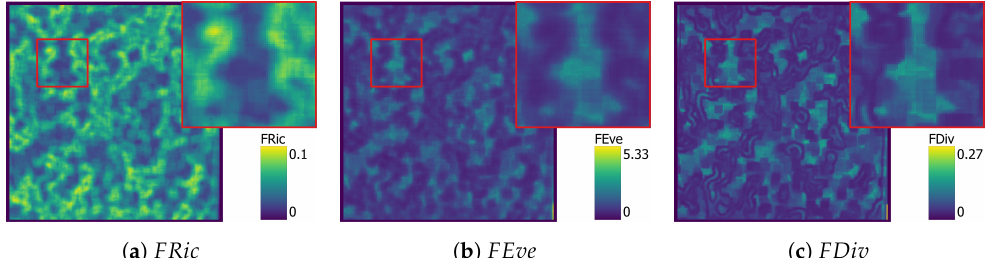
Figure 9. PCA, from four traits, functional diversity maps with FRic , FEve , and FDiv in their own figure.